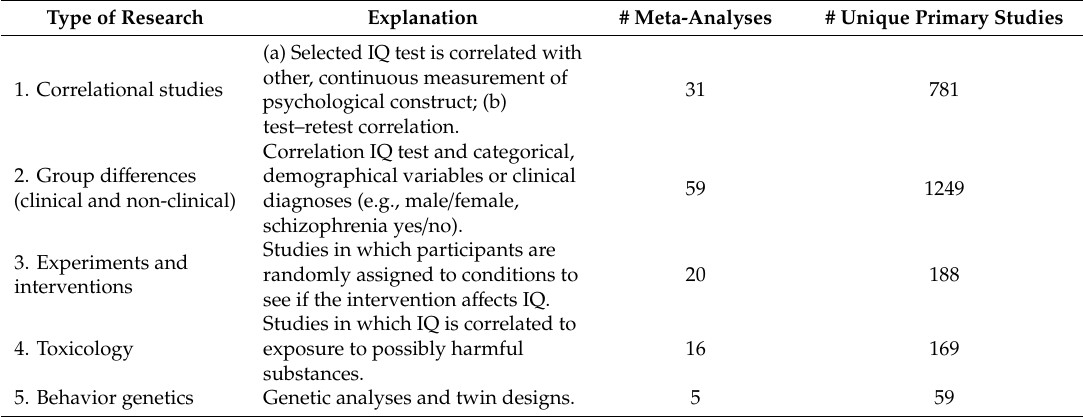
Table 1. The number of included meta-analyses and primary studies per